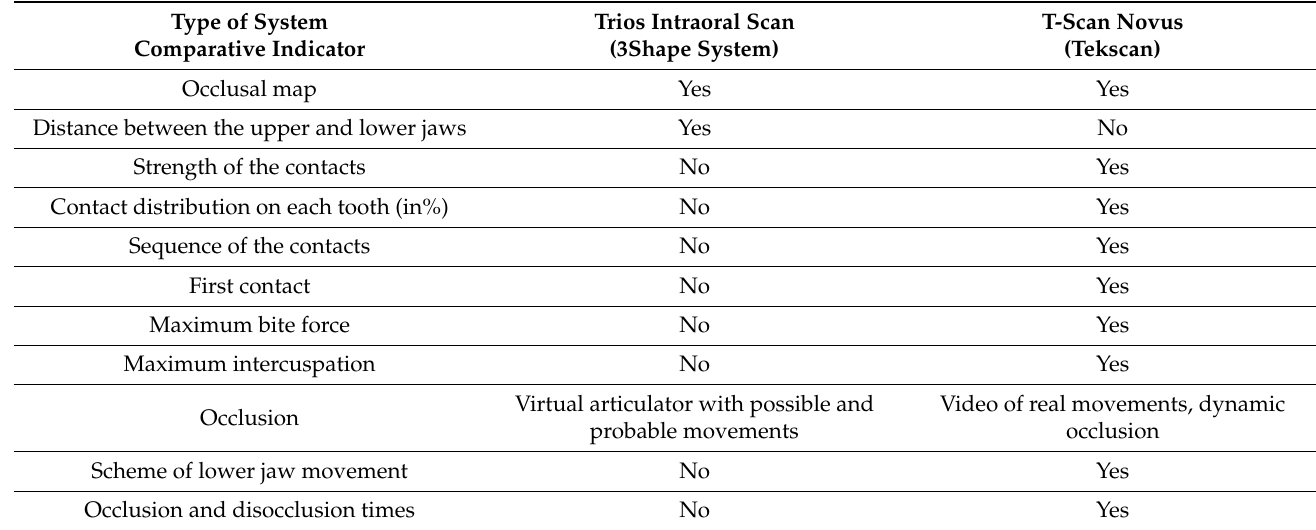
Table 2. Comparison between intraoral scanning and digital occlusion determination with the T-Scan system.